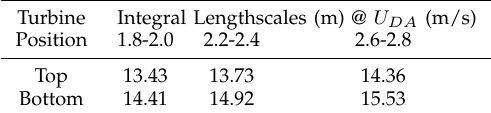
TABLE III H UB HEIGHT INTEGRAL LENGTHSCALES CALCULATED FROM MEASURED DATA FOR THREE DIFFERENT FLOW SPEED BINS